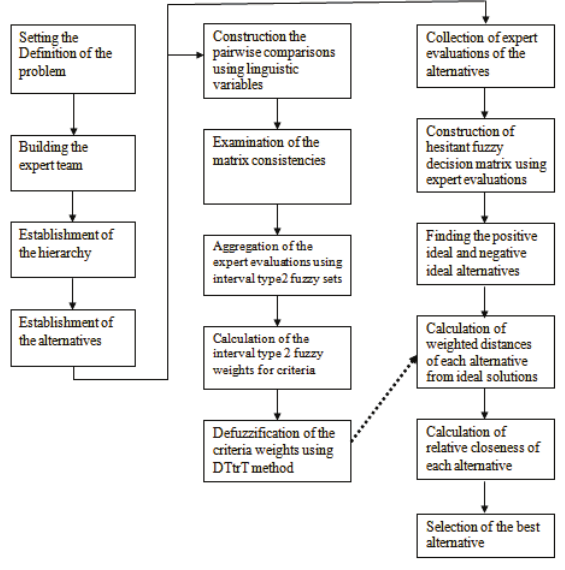
Figure 3: Flow chart of the proposed